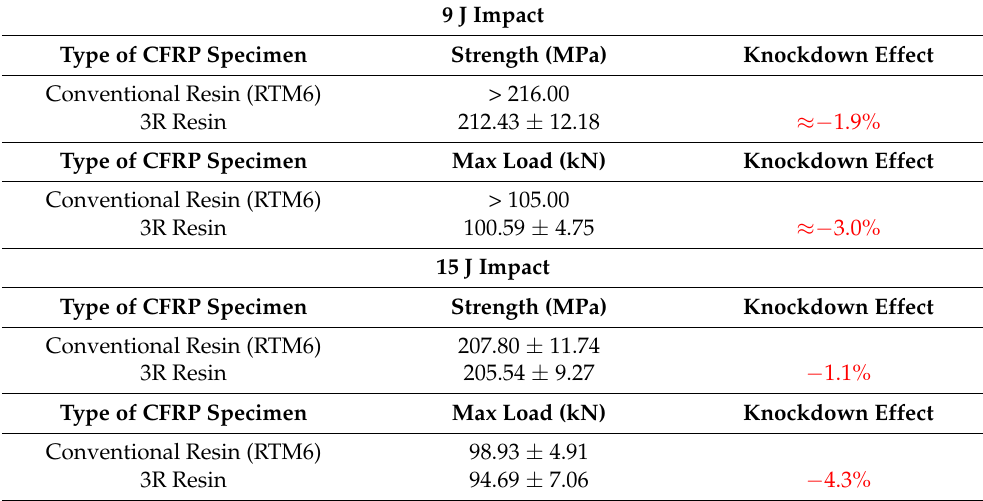
Table 6. Knockdown effect of compression after impact properties between conventional (RTM6) and 3R